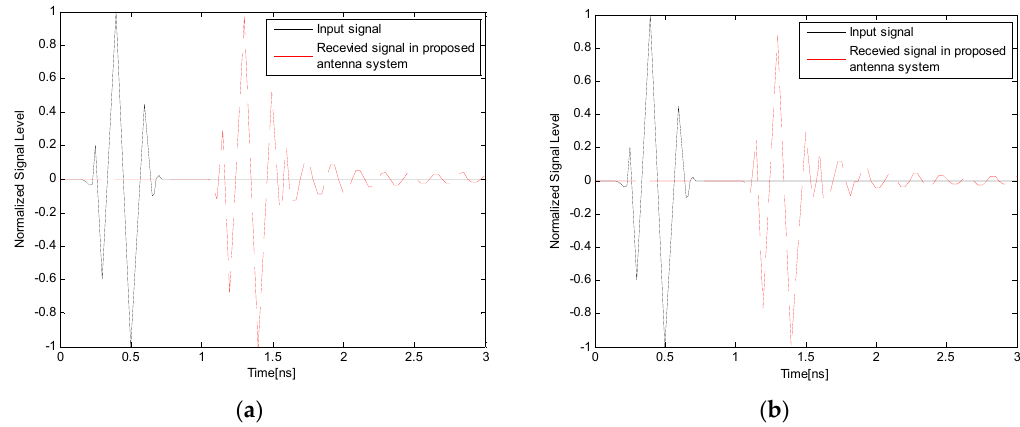
Figure 17. Input and received pulse waveforms of the proposed antenna: ( a ) in face-to-face scenario; and ( b ) in side-by-side scenario.